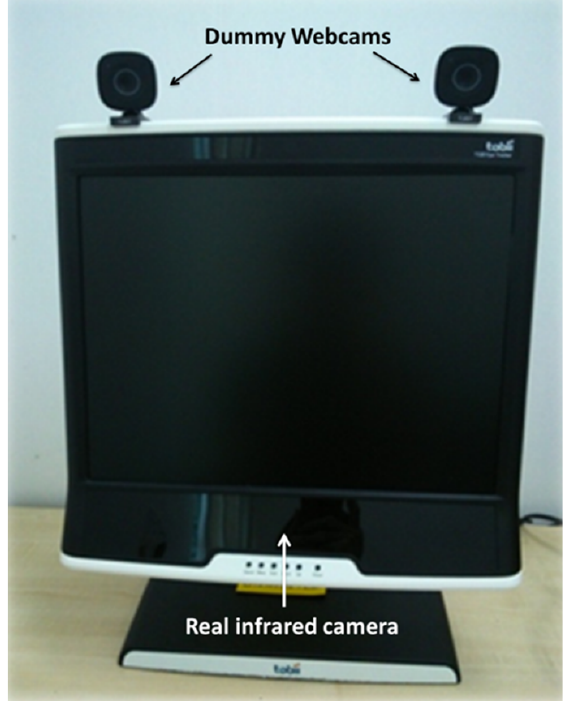
Figure 1. Equipment setup of the study, showing dummy webcams on top of the eye tracker